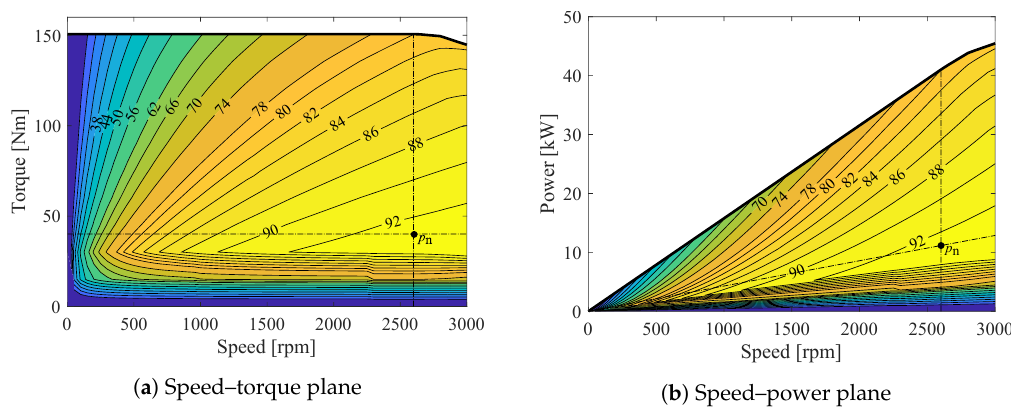
Figure 14. Efficiency map of the designed electric motor. The dashed lines indicate the rated torque or power and rated speed